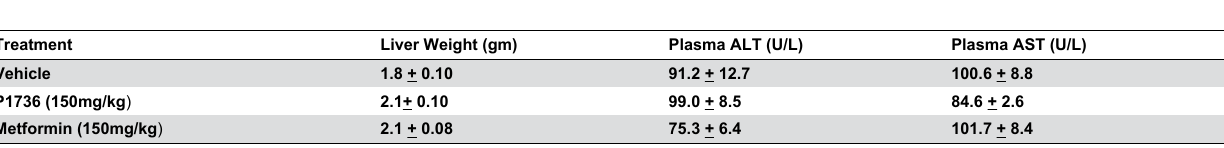
Table 2. Effect of P1736 on Liver safety parameters in db/db mice.